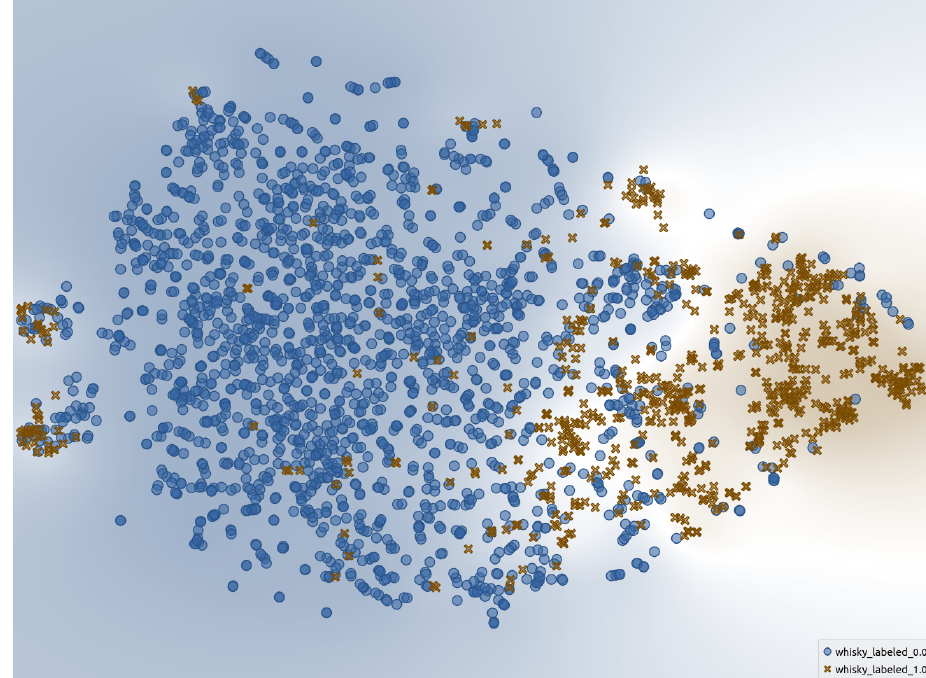
Figure 11. t-SNE representation of the training data where a blue dot represents a word labeled as a non-descriptor, and a brown ’‘X” represents those that are descriptors.